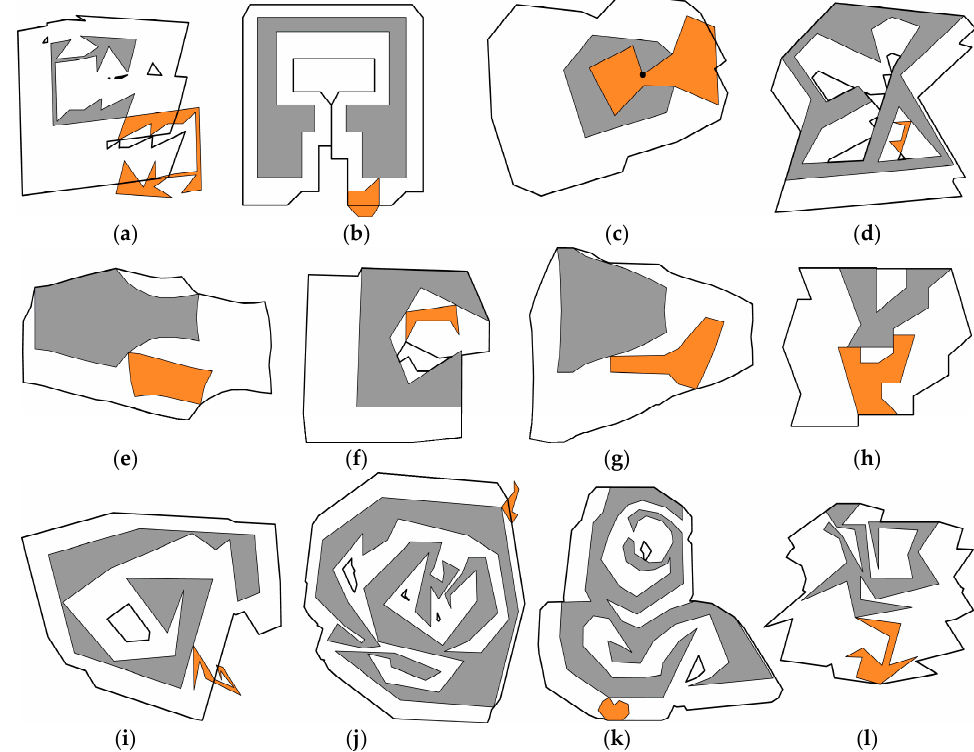
Figure 13. NFPs of degenerate cases and complex instances from published literature. ( a ) NFP with holes; ( b ) An example of exact sliding; ( c ) The jigsaw-type; ( d )NFP with holes; ( e ) An example from “swim” instance; ( f ) Polygon with narrow entrance; ( g ) An example from “swim” instance; ( h ) An example from literature; ( i ) Instance from literature; ( j ) Instance f from literature; ( k ) Instance from literature; ( l ) Instance from